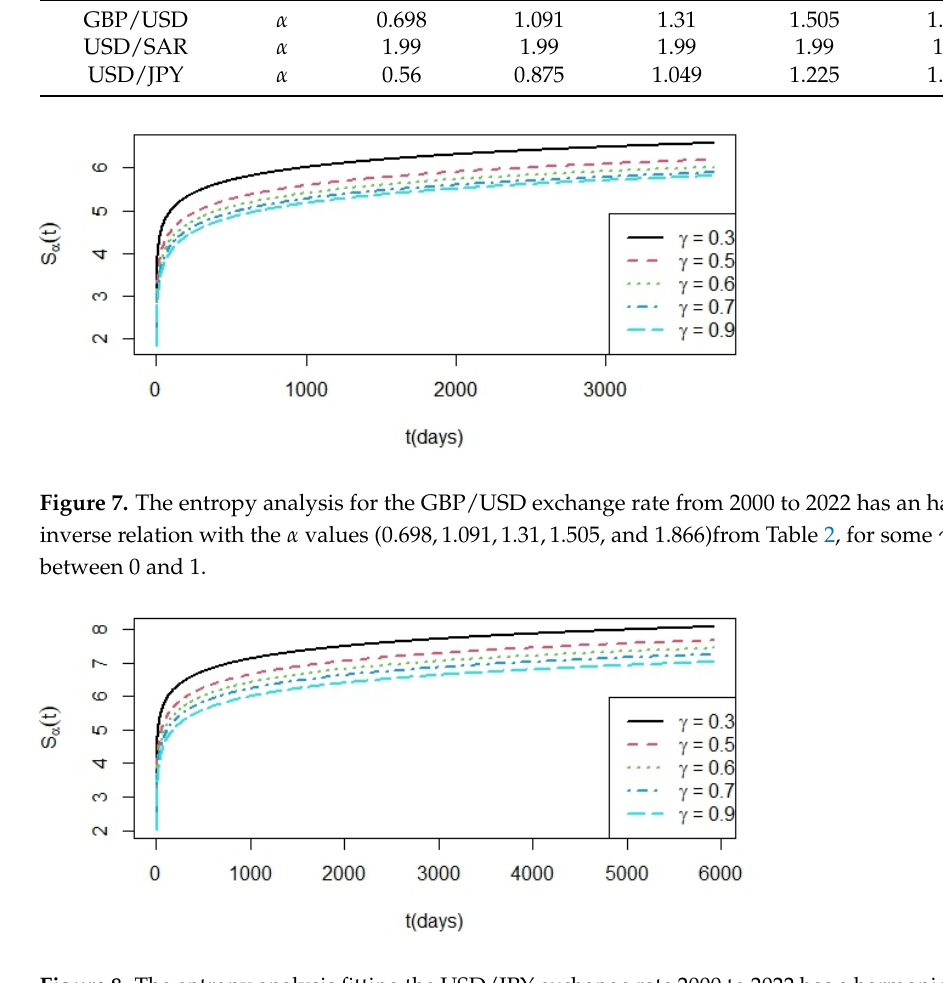
Figure 8. The entropy analysis fitting the USD/JPY exchange rate 2000 to 2022 has a harmonic inverse relation of the α = 0.56,0.875,1.049,1.225 and 1.565 from Table 2 which are estimated for some values of γ ∈ ( 0,1 )